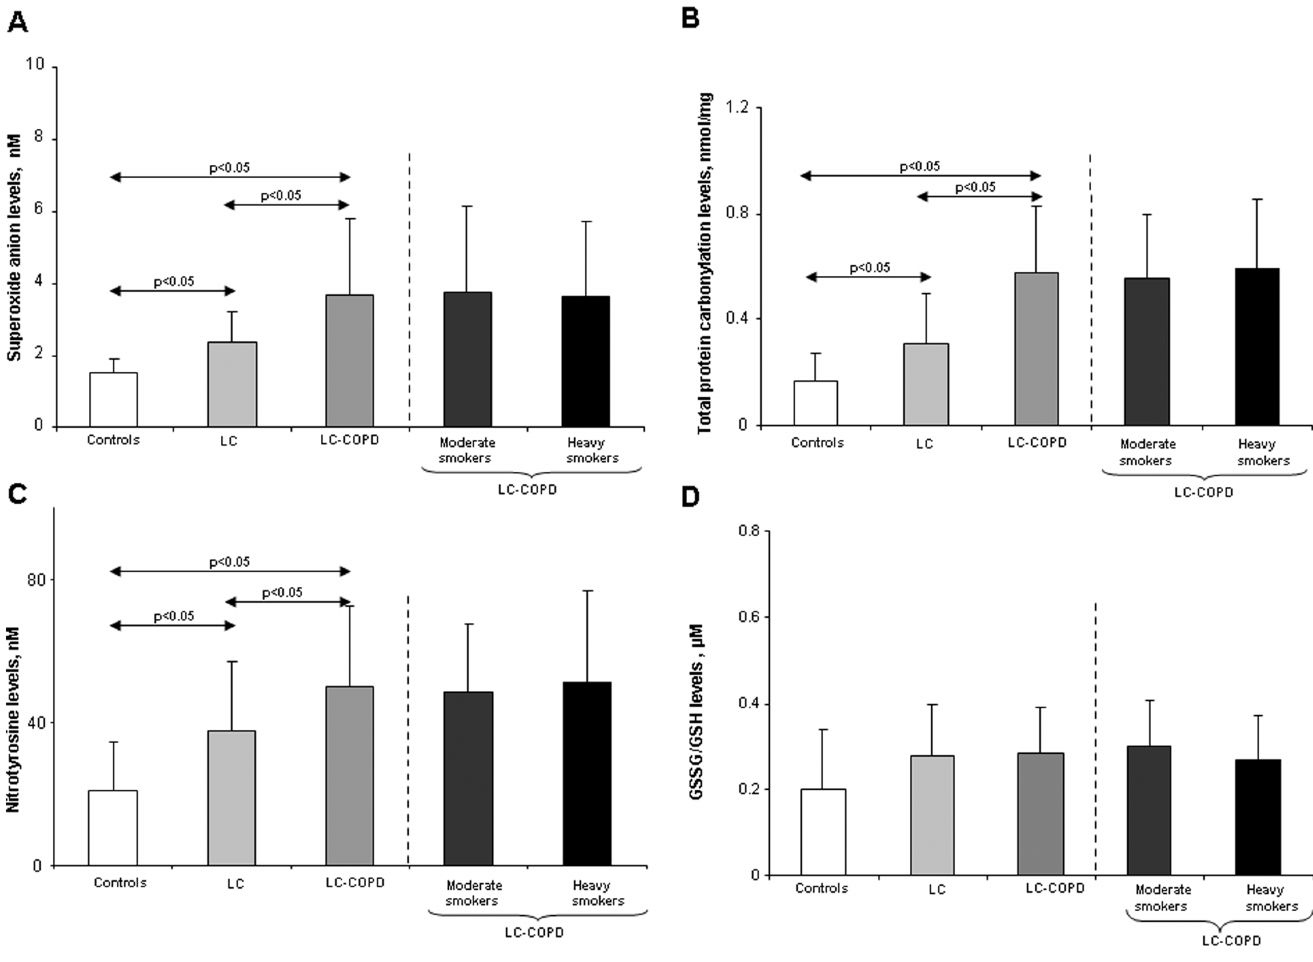
Figure 4. (A) Mean values and standard deviation of total blood superoxide anion measured by lucigenin-derived chemiluminescence (20 micromol/L) were significantly higher in both LC and LC-COPD compared with controls. Blood superoxide anion levels were also greater in LC-COPD compared with LC patients. The absence of any statistical sign means that no significant differences were found between groups for the different study comparisons. (B) Mean values and standard deviation of total blood protein carbonylation as measured by ELISA (nmol/mg) were significantly higher in both LC and LC-COPD patients compared with controls. Total blood protein carbonylation levels were also increased in LC-COPD compared with LC patients. The absence of any statistical sign means that no sig- nificant differences were found between groups for the different study comparisons. (C) Mean values and standard deviation of blood protein tyrosine nitration as measured by ELISA (nmol/L) were significantly greater in LC and LC-COPD patients compared with controls. Blood nitrotyrosine levels were also higher in LC-COPD compared with LC patients. Significant p values ( p < 0.05) that correspond to comparisons between the different groups of patient and types of samples (blood and lung specimens) are indicated using an arrow in each case. The absence of any statistical sign means that no significant differences were found between groups for the different study comparisons. (D) Mean values and standard deviation of GSSG/GSH as measured by ELISA ( μ mol/L) in the blood did not signifi- cantly differ among the study groups of patients. The absence of any statistical sign means that no significantly differences were found between groups for the different study